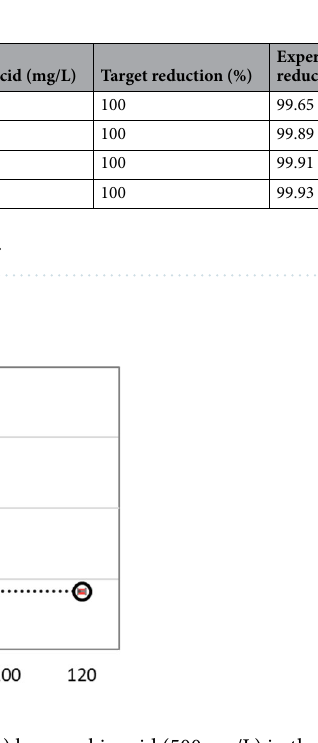
Figure 6. Reduction kinetics of Cr(VI) (100 mg/L) by ascorbic acid (500 mg/L) in the presence of humic acid (20